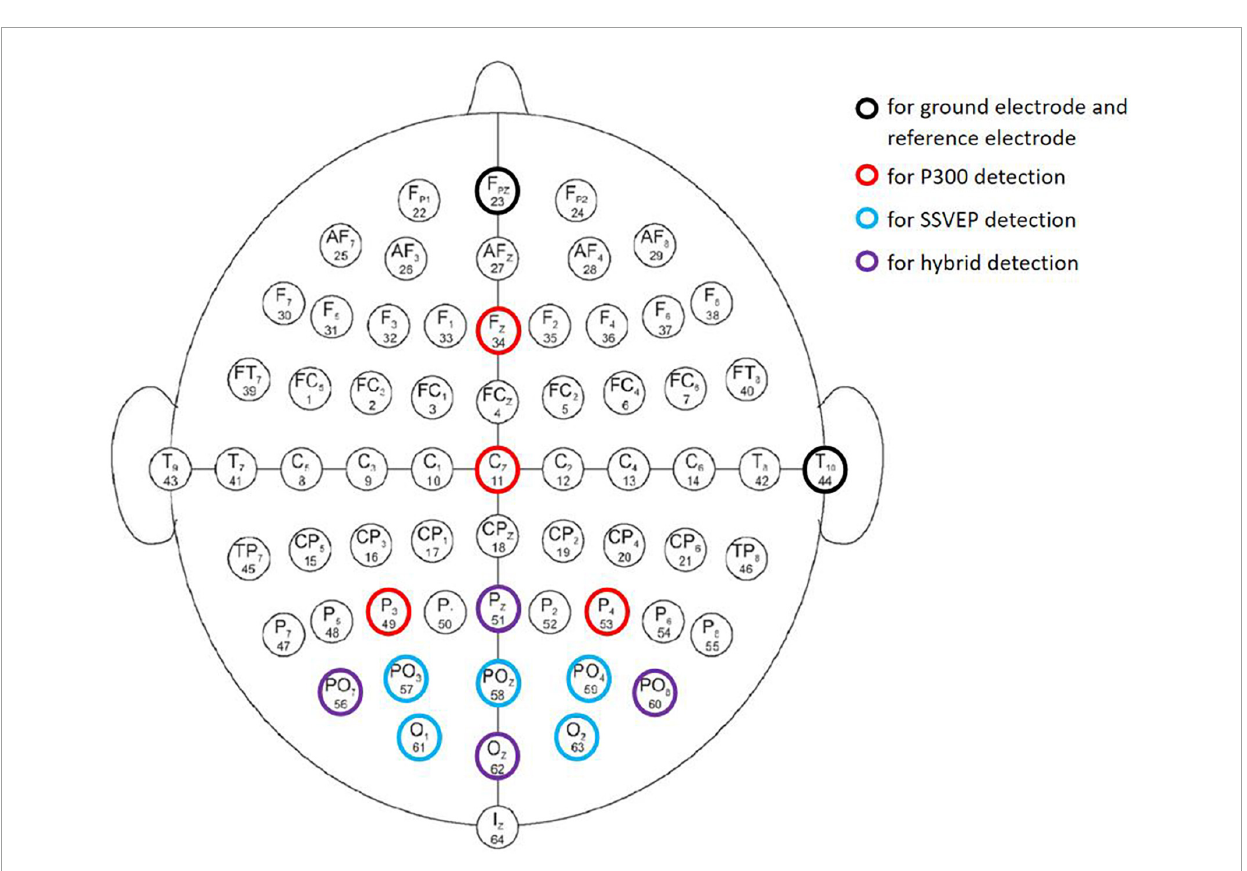
passed into the five support vector machine (SVM) classifiers trained in advance, and then the classification results are fed into the modified weight controller to derive the P300